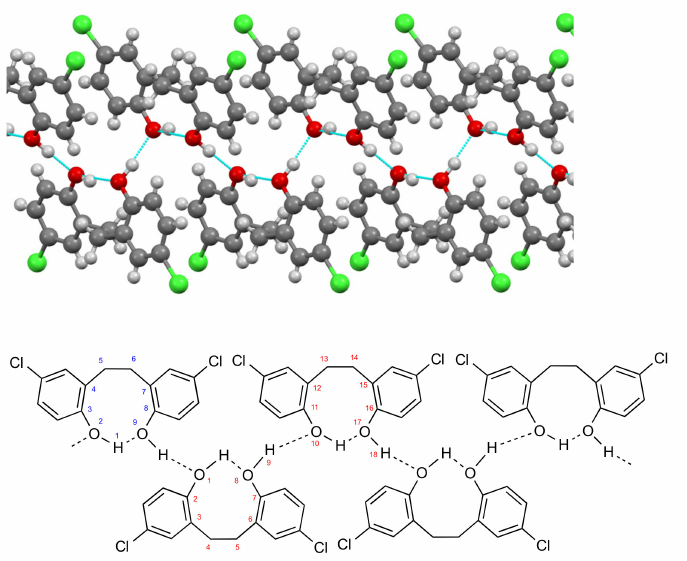
Figure 4. Hydrogen bonding pattern for compound 1 viewed to avoid molecular overlap, together with schematic representation showing derivation of graph set descriptors.